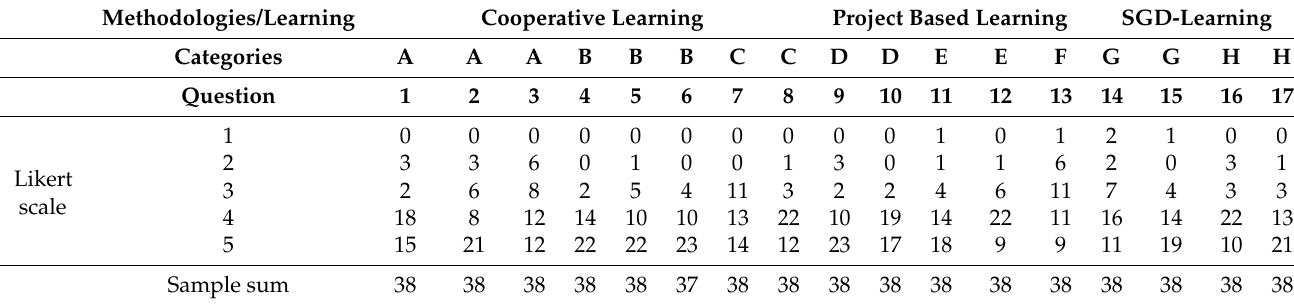
Table 1. Absolute frequencies of responses on active methodologies (block 1). Methodologies/Learning Cooperative